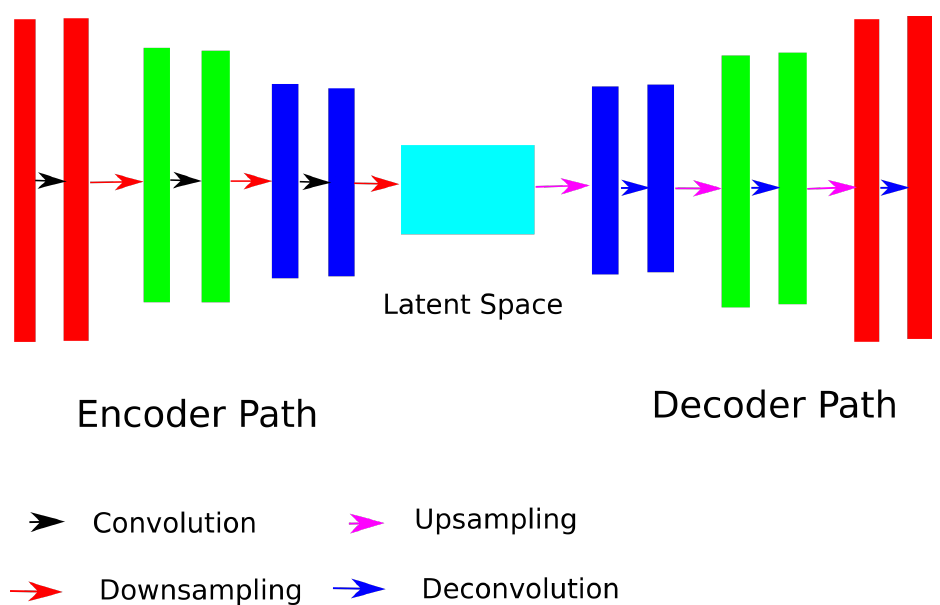
Figure 2. The schematic diagram of the SegNet architecture. This model is also divided into the expansion and contraction paths but does not include any skip